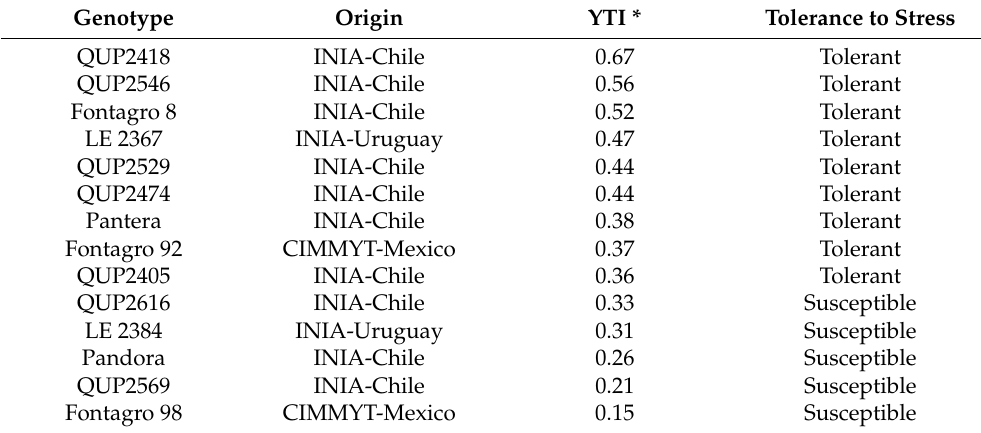
Table 6. The 14 selected wheat genotypes and their level of tolerance to water stress, according to the yield tolerance index (YTI) determined in two Mediterranean